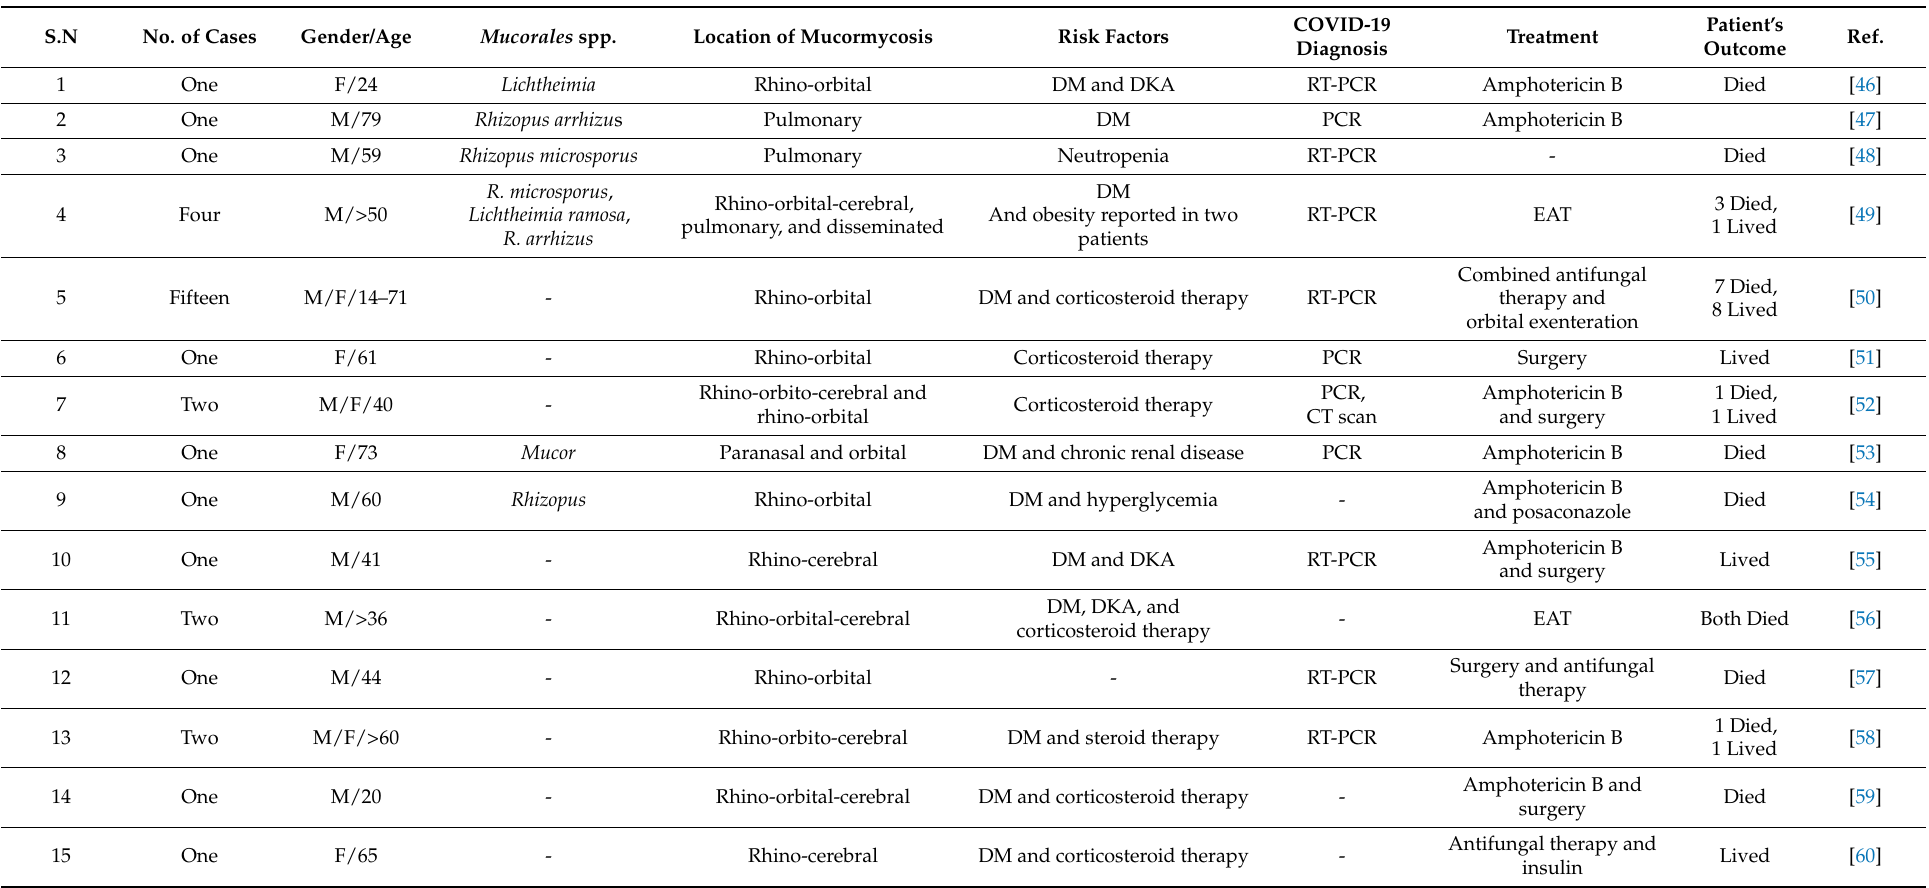
Table 1. Summary of various case reports of COVID-19-associated mucormycosis discussed in this article. DM, diabetes mellitus and DKA, diabetic ketoacidosis. EAT, empiric antifungal therapy or observation-based antifungal therapy is followed in high-risk patients who have persistent fever after 4–7 days of broad-spectrum anti-bacterial drugs and no identified infection source. Some of the drugs used in EAT are amphotericin B, caspofungin, micafungin, voriconazole, itraconazole, and